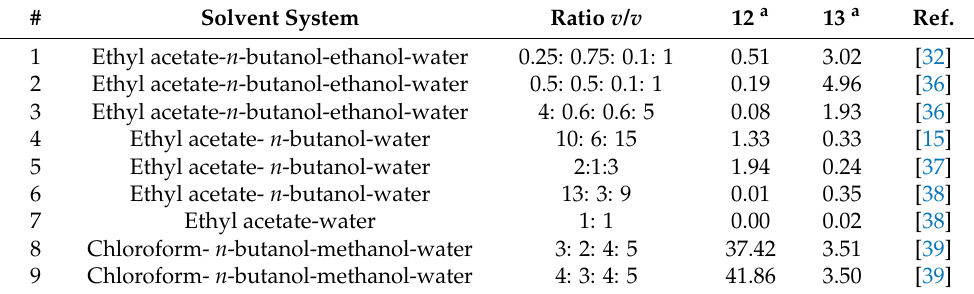
Table 3. Partition coefficients (K D ) of compounds 12 and 13 in two-phase solvent